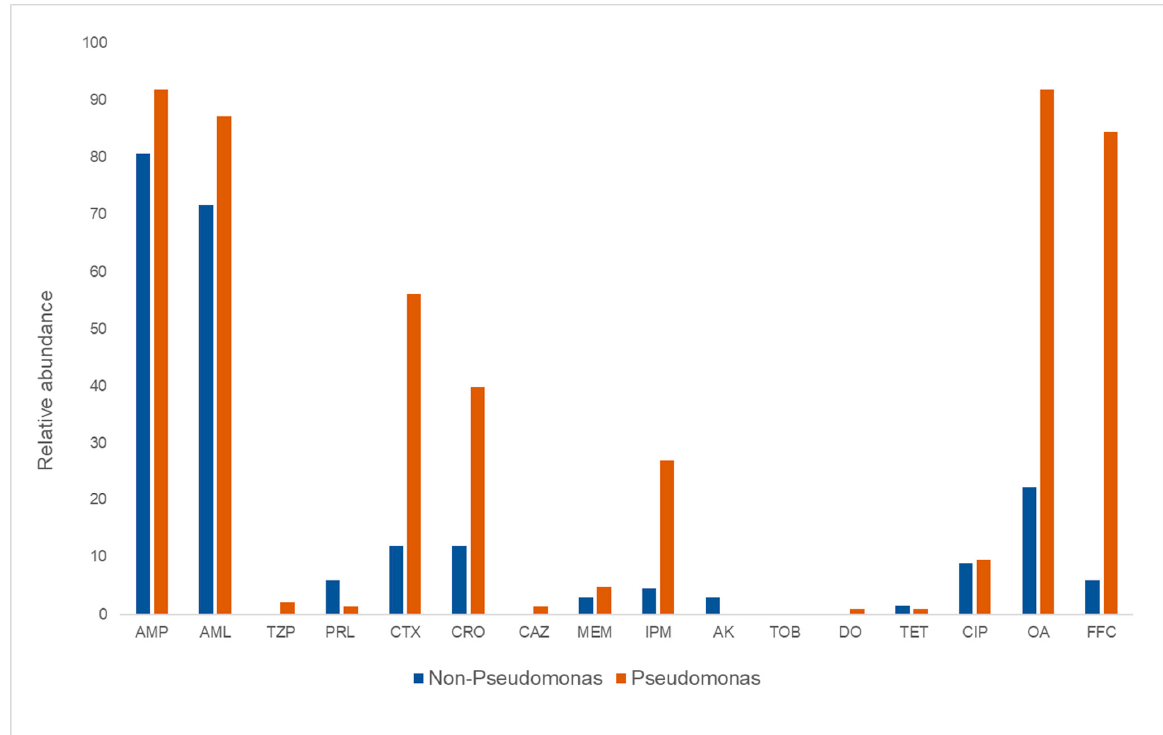
Figure 2. Relative abundance of Pseudomonas and non -Pseudomonas isolates sampled from different sampling points in a salmon processing facility harboring phenotypical resistance towards sixteen different antibiotics. AMP-ampicillin, AML-amoxicillin, TZP-piperacillin/tazobactam, PRL-